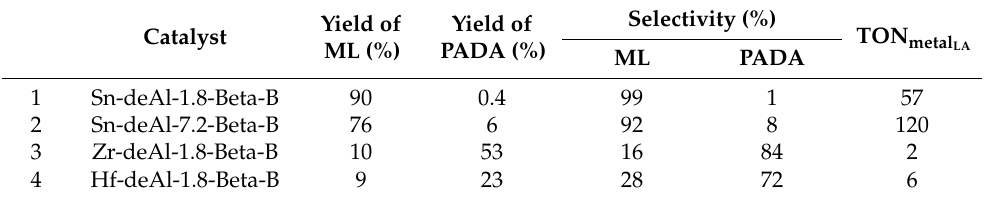
Table 2. Catalytic performance of Sn-, Zr- and Hf-containing zeolite Beta beads in the conversion of dihydroxyacetone (DHA) into methyl lactate (ML). Selectivity (%) Yield of Yield of Catalyst ML (%) PADA (%)